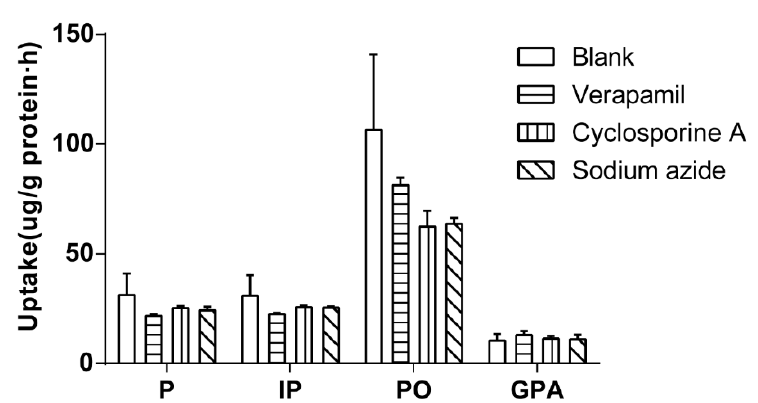
Figure 5. The cellular uptake of the 4 component compounds with the present of inhibitors.